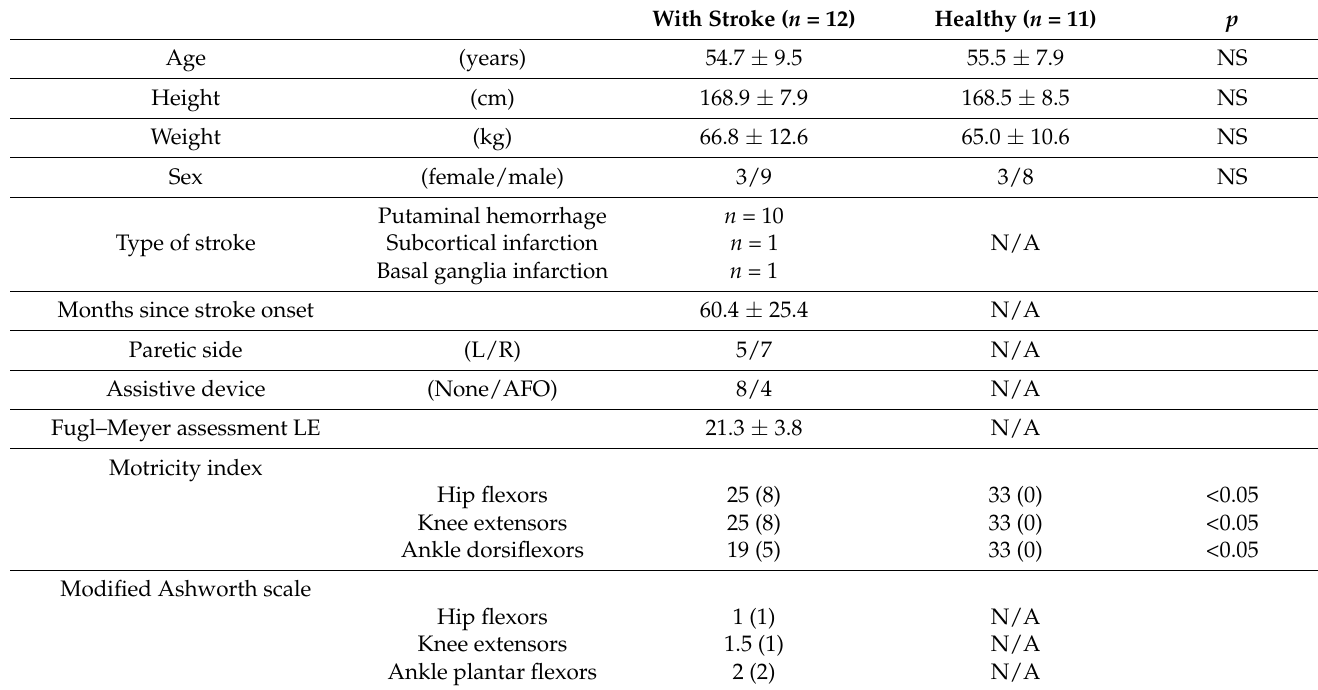
Table 1. Characteristics of